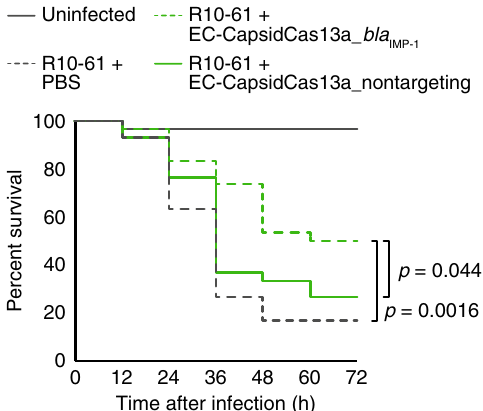
Fig. 4 Potential of CapsidCas13a as a therapeutic against AMR bacteria infections. Examination of the therapeutic effect of EC-CapsidCas13a- bla Galleria mellonella infection model. Administration of EC- IMP-1 using a CapsidCas13a- bla IMP-1 (MOI 100) into G. mellonella larvae infected with R10-61 (carbapenem-resistant clinical isolates of E. coli carrying bla IMP-1 ) signi fi cantly improved host survival compared to controls, EC- CapsidCas13a-nontargeting ( p = 0.044), and phosphate-buffered saline (PBS; p = 0.0016). The p -value between two groups infected with R10-61, and treated with EC-CapsidCas13a-nontargeting and PBS was 0.30. The p - values are calculated by log-rank test. The results are presented as the aggregate values of three independent experiments performed using ten larvae per group. Source data are available in the Source Data fi